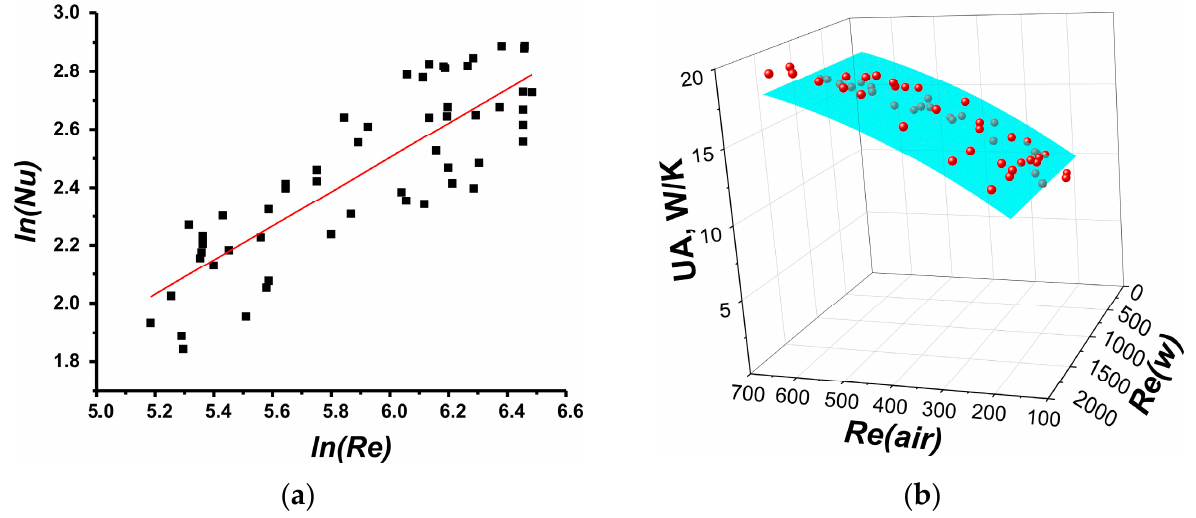
Figure 8. ( a ) Nu number correlation for radiator R2; ( b ) Comparison of experimental data (red symbols) and approximation (blue 3D surface) calculated by found correlation.